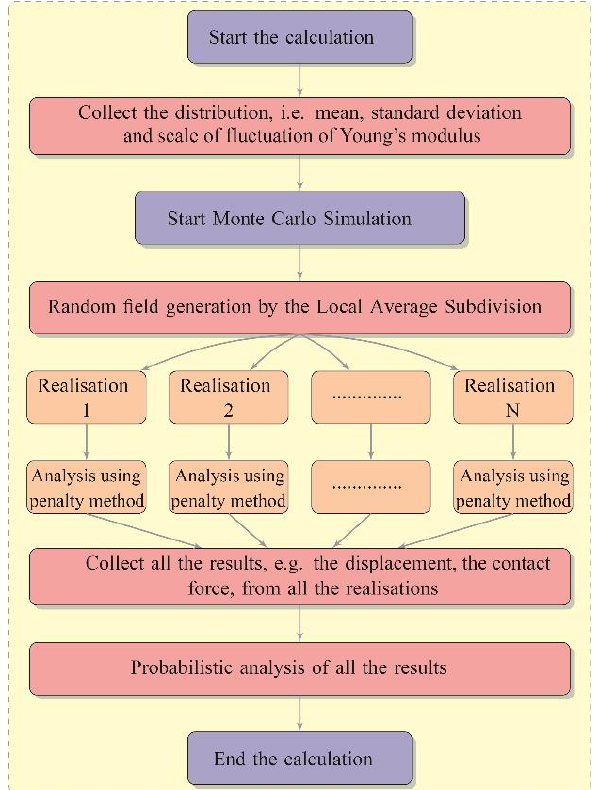
Figure 2. Flowchart of the proposed method.